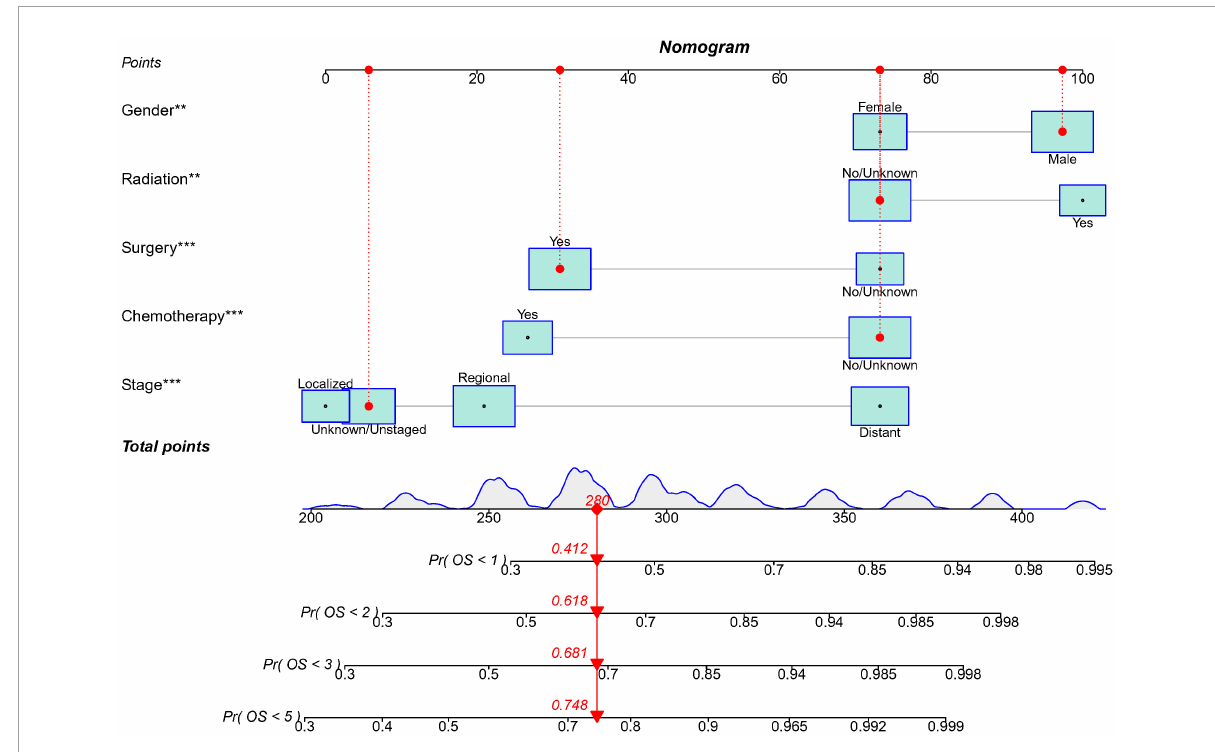
FIGURE4 The nomogram model to predict the 1, 2, 3, and 5-years survival probability in PCS patients. ** indicates p < 0.01; *** indicates p < 0.001.